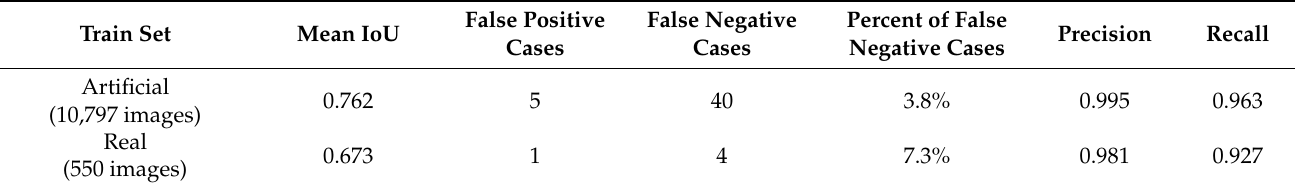
Table 7. Final comparison of the results between artificial and real